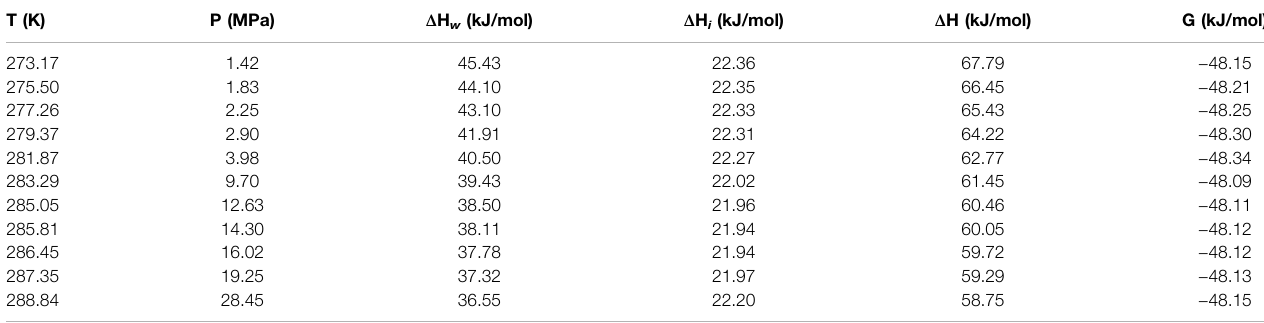
TABLE 2 | Data of carbon dioxide hydrate phase transition (partial).